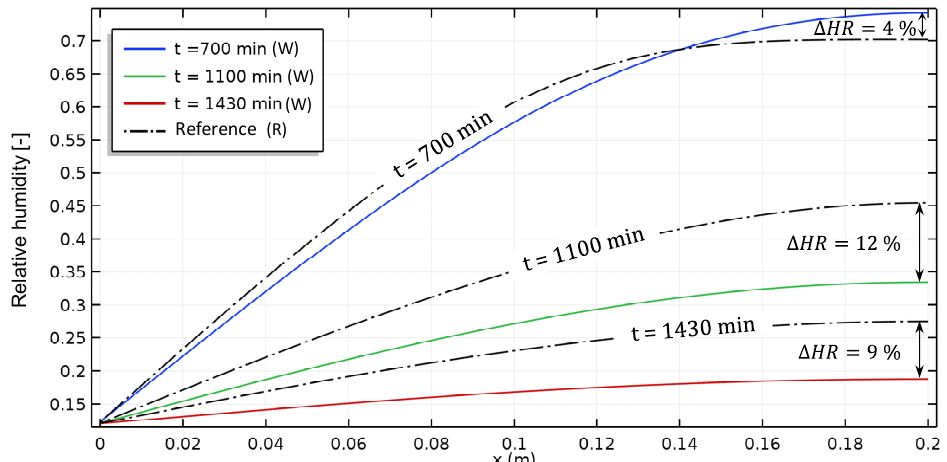
Figure 7. Isothermal case: Relative humidity profiles of aged (W) and reference (R) hemp concrete: (discontinuous line: reference material and continuous line: aged material).